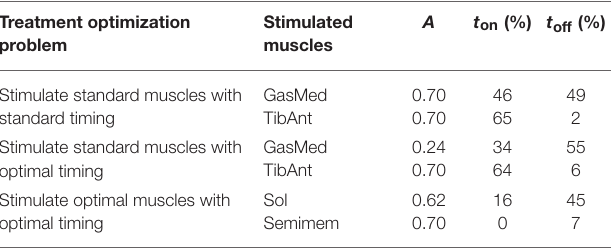
TABLE 7 | Muscle stimulation parameters found by FastFES treatment optimizations.